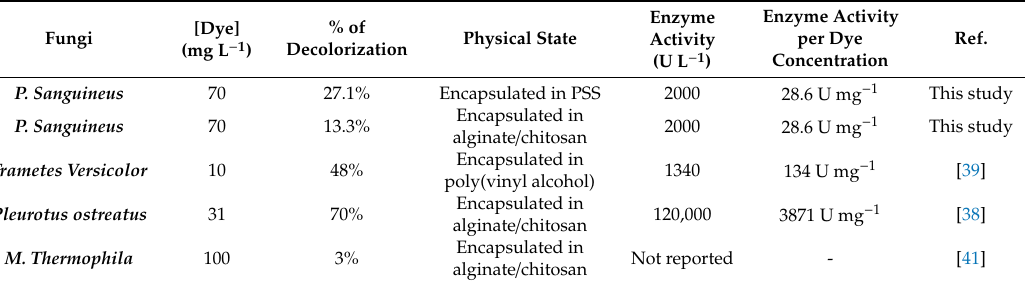
Table 3. Comparison between laccases from di ff erent